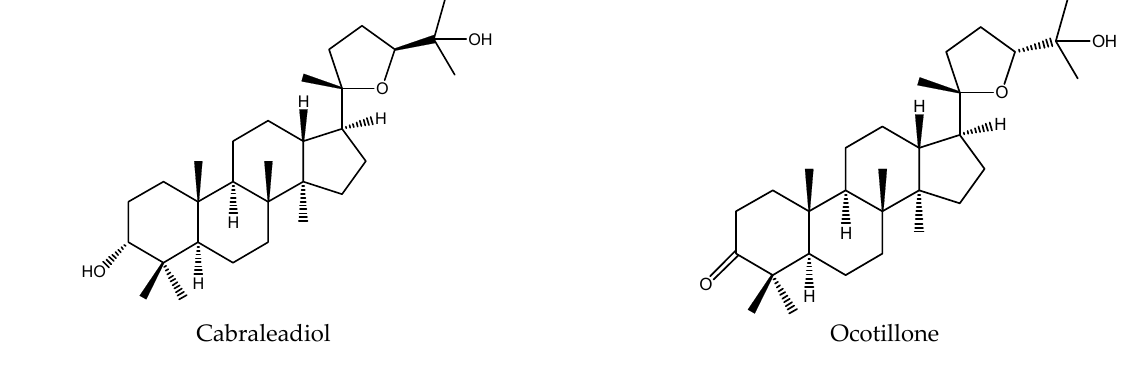
Figure 19. The structures of dammaranes.